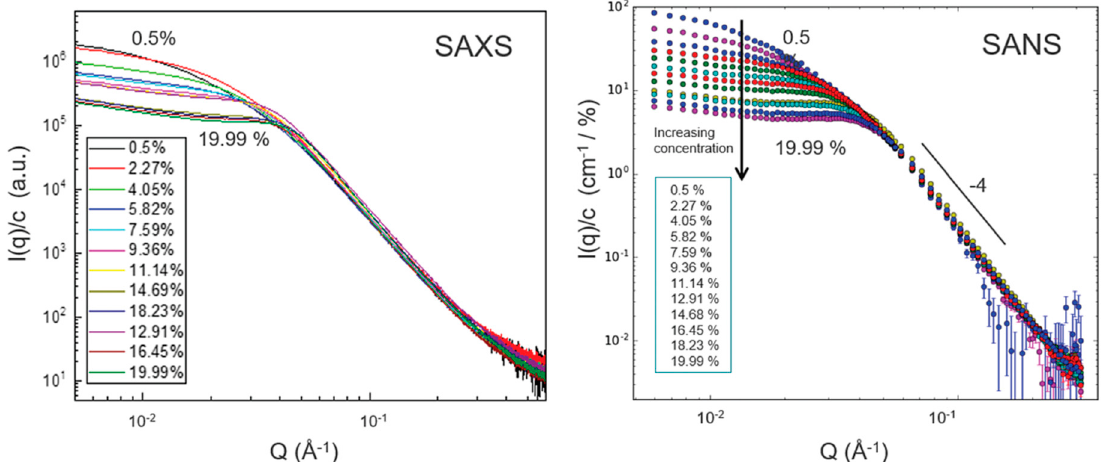
Figure 16. SAXS and SANS intensities normalized to the concentration of MNPs(Fe 3 O 4 /CA) with varying concentration. The SANS data have been background-subtracted for the H 2 O contribution. Reproduced from Reference [85] with permission from The Royal Society of Chemistry.